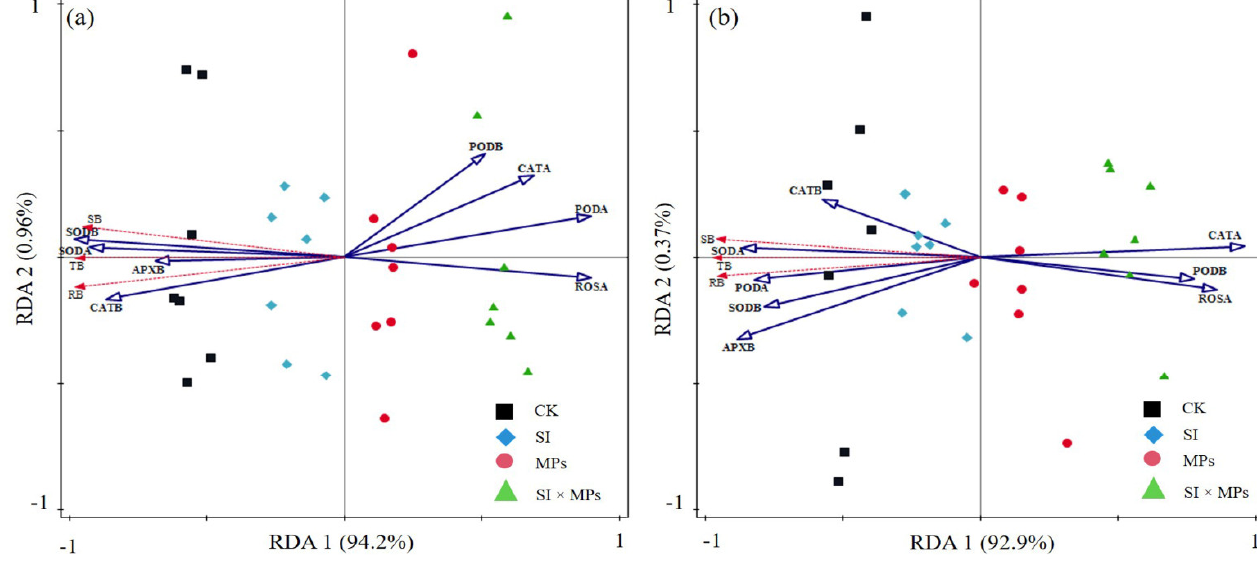
Figure 2. Redundancy analysis (RDA) of the antioxidant enzyme and biomass representing at the ( a ) 50th and ( b ) 80th days after transplanting, while the in-between antioxidant enzyme and photo- synthetic parameters are represented at the ( c ) 50th and ( d ) 80th days after transplanting of the rice crop. CK = control treatment; SI = Solidago canadensis L. invasion treatment; MPs = soil microplastics residual treatment; SI × MPs = combination of S. canadensis invasion treatment and soil microplastics residual treatment; RB = root biomass; SB = stem biomass; TB = total biomass; Pn = net photosyn- thetic rate; Tr = transpiration rate; Gs = stomatal conductance; PAR = photosynthetically active radi- ation; Ci = intracellular CO 2 concentration; WUE = water-use efficiency; Leaf N = leaf nitrogen; APXB = ascorbate peroxidase in belowground; APXA = ascorbate peroxidase in aboveground; CATB = catalase in belowground; CATA = catalase in aboveground; PODB = peroxidase in belowground; PODA = peroxidase in aboveground; SODB = superoxide dismutase in belowground; SODA = su- peroxide dismutase in aboveground; ROSB = reactive oxygen species in belowground; ROSA = re- active oxygen species in aboveground.